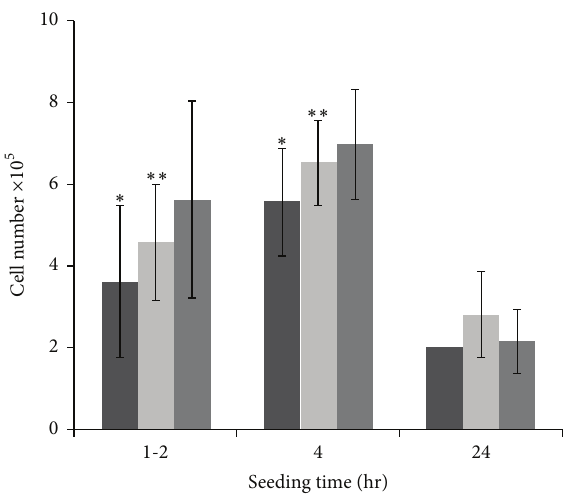
Figure 2: NCI-H460 cell number counted at day 4 of scaffold culture with 3 × 10 5 (dark grey), 7 × 10 5 (light grey) and 1.5 × 10 6 (grey) as initial seeding cell number for 1-2 hours, 4 hours and 24 hours.Thereisasignificantdifferencebetween1-2hoursand4hours seeding; ∗ 𝑃 < 0.05 , ∗∗ 𝑃 < 0.01